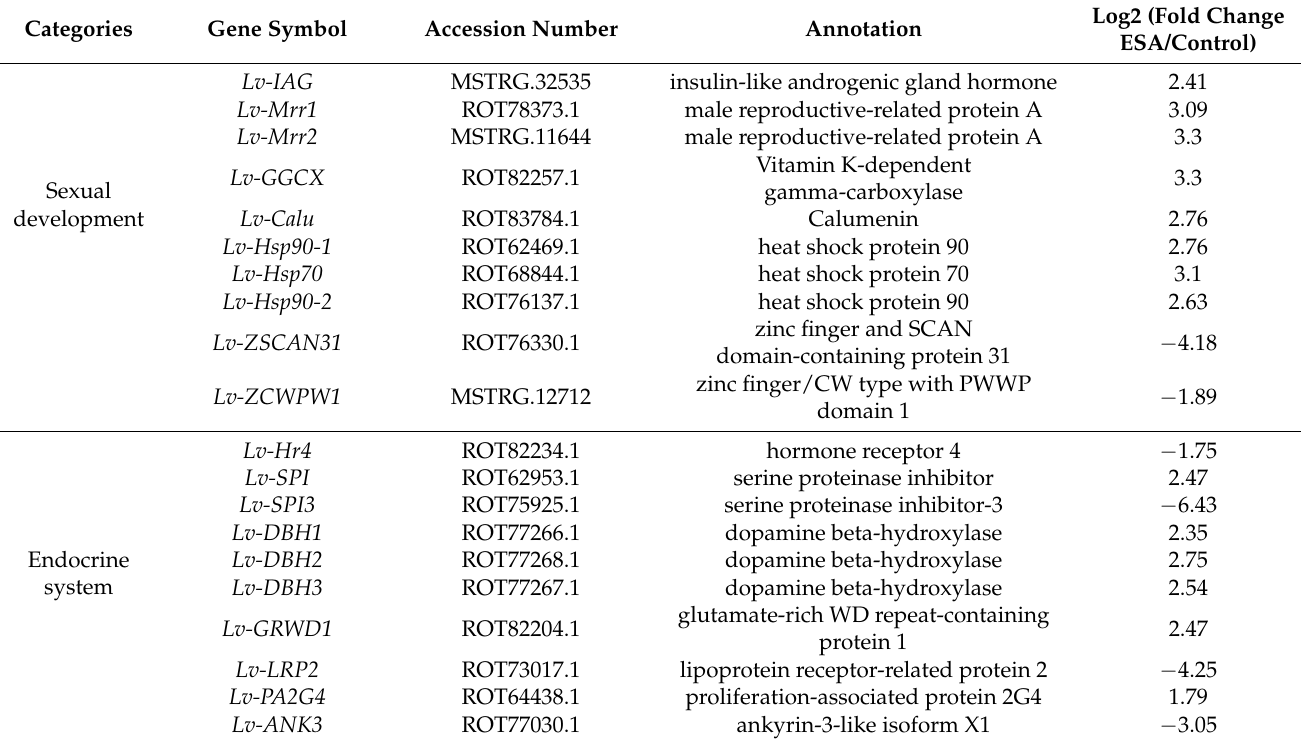
Table 2. Identified DEGs related to sexual development and